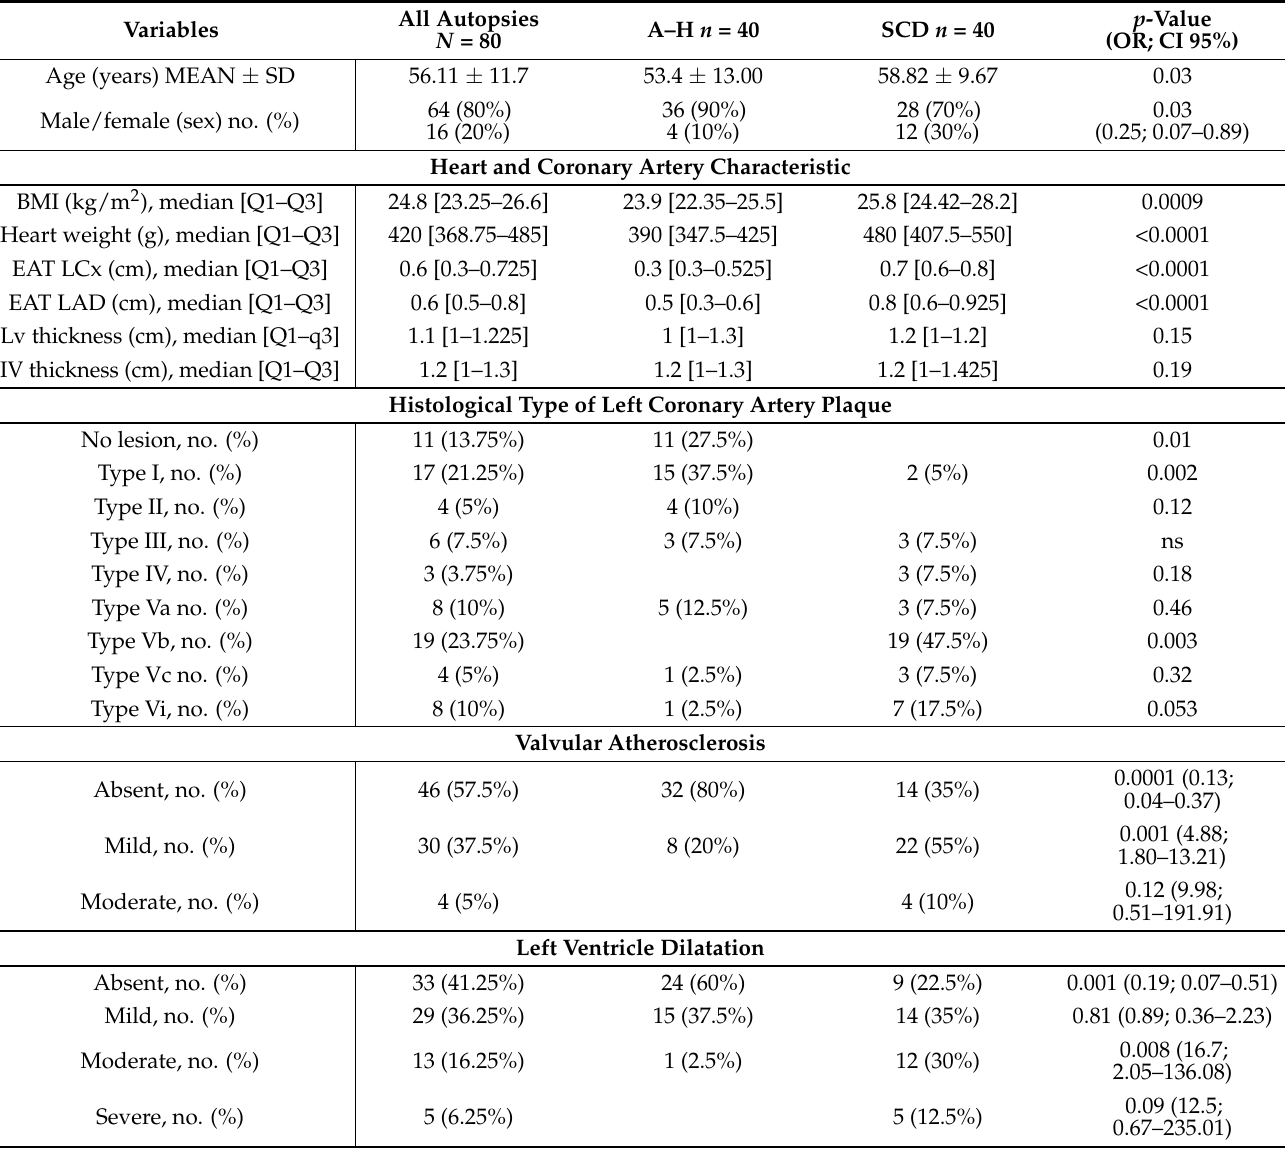
Table 1. All characteristics regarding the demographic, heart, valvular, and coronary artery of all the autopsies that were included.